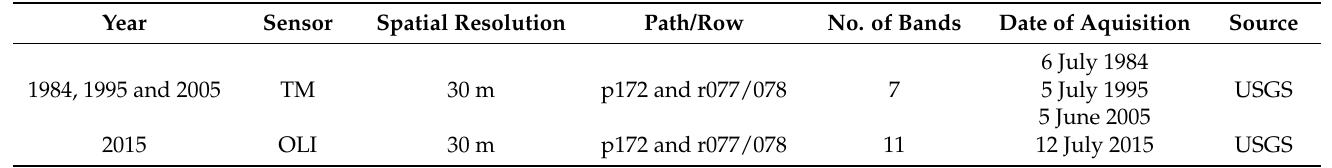
Table 1. Landsat image characteristics used for the study